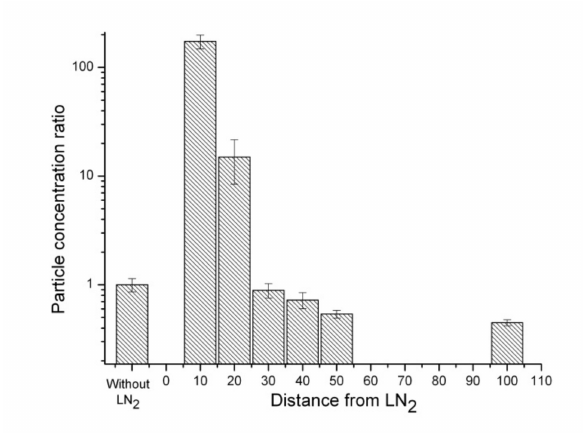
Figure 3. Concentration ratios of particles of size 3 µ m at distances of 10, 20, 30, 40, 50, and 100 cm from the LN 2 surface.